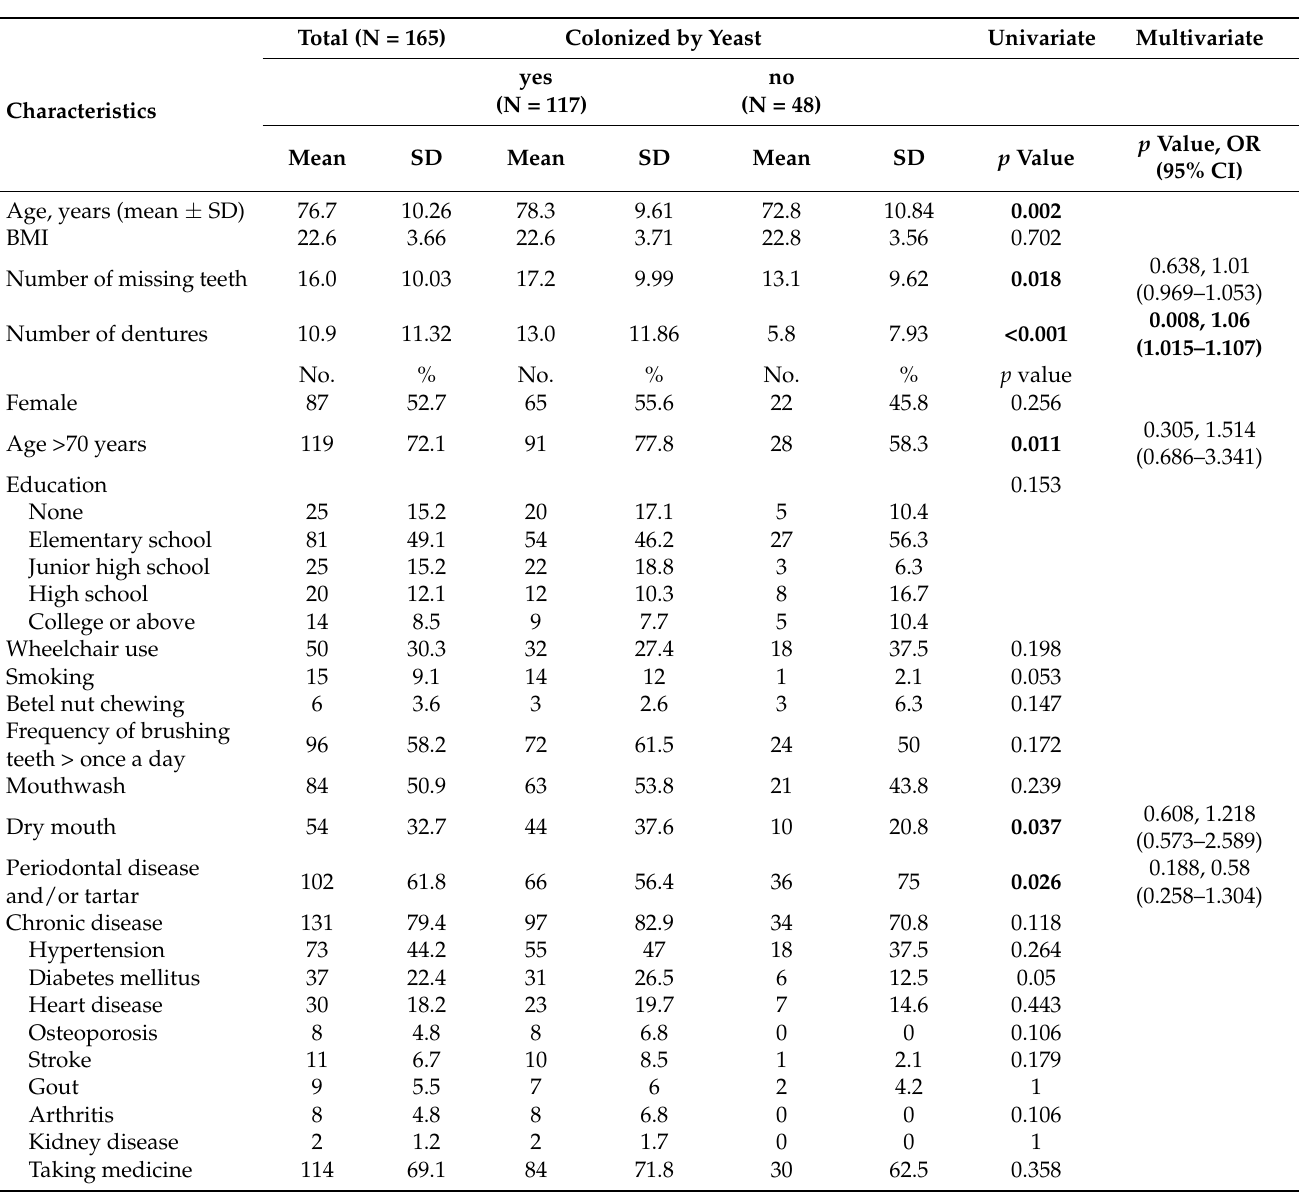
Table 1. Risk factors of residents colonized by